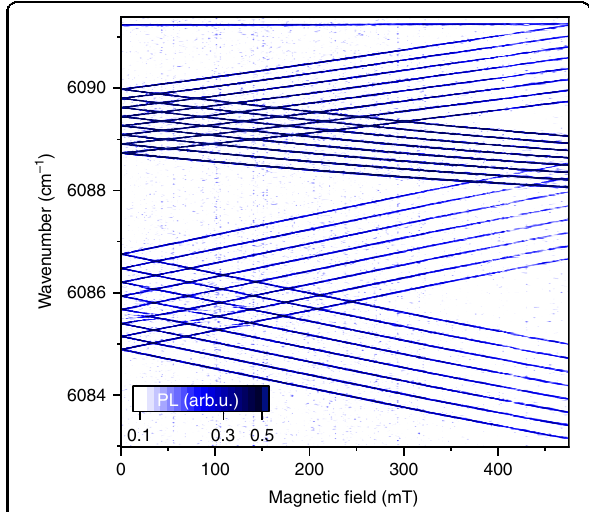
Fig. 5 Evolution of the hyper fi ne structure with increasing magnetic fi eld B || c . Photoluminescence intensity map in the magnetic- fi eld – wavenumber scale for two transitions from the 5 I 5 Г 34 (11,241.6) CF level to the levels of the 5 I 7 CF multiplet: 5 I 7 Г 2 (5152.3) (top line) and 5 I 7 Г 34 (5155.75) (bottom line). 7 LiYF 4 :Ho 3 + (0.1 at. %), T = 10 K. B || c